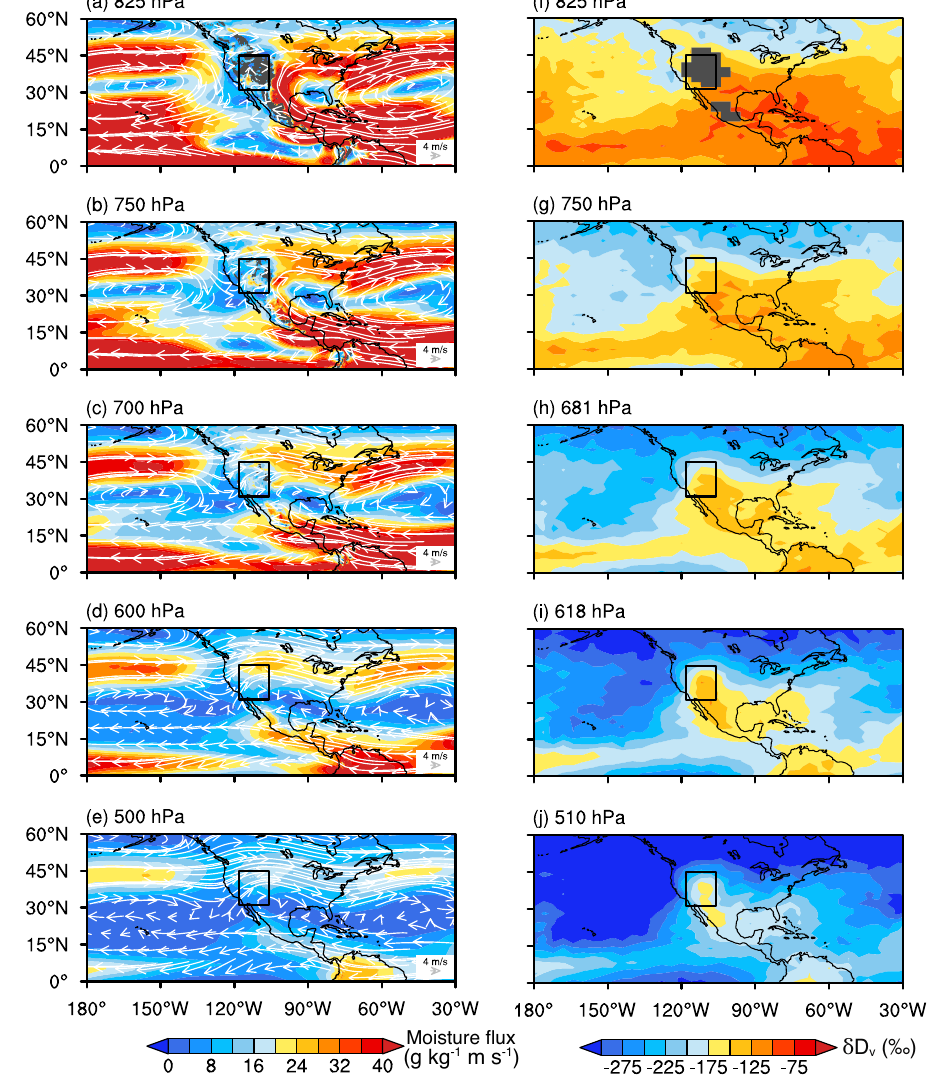
f indicatesthatnovalid δ D v dataareavailableforthespeci fi cgrid.Blackboxineach panel represents the WUSA (western United States of America). This map was generated with The NCAR Command Language (Version 6.6.2) [Software]. (2019). Boulder, Colorado: